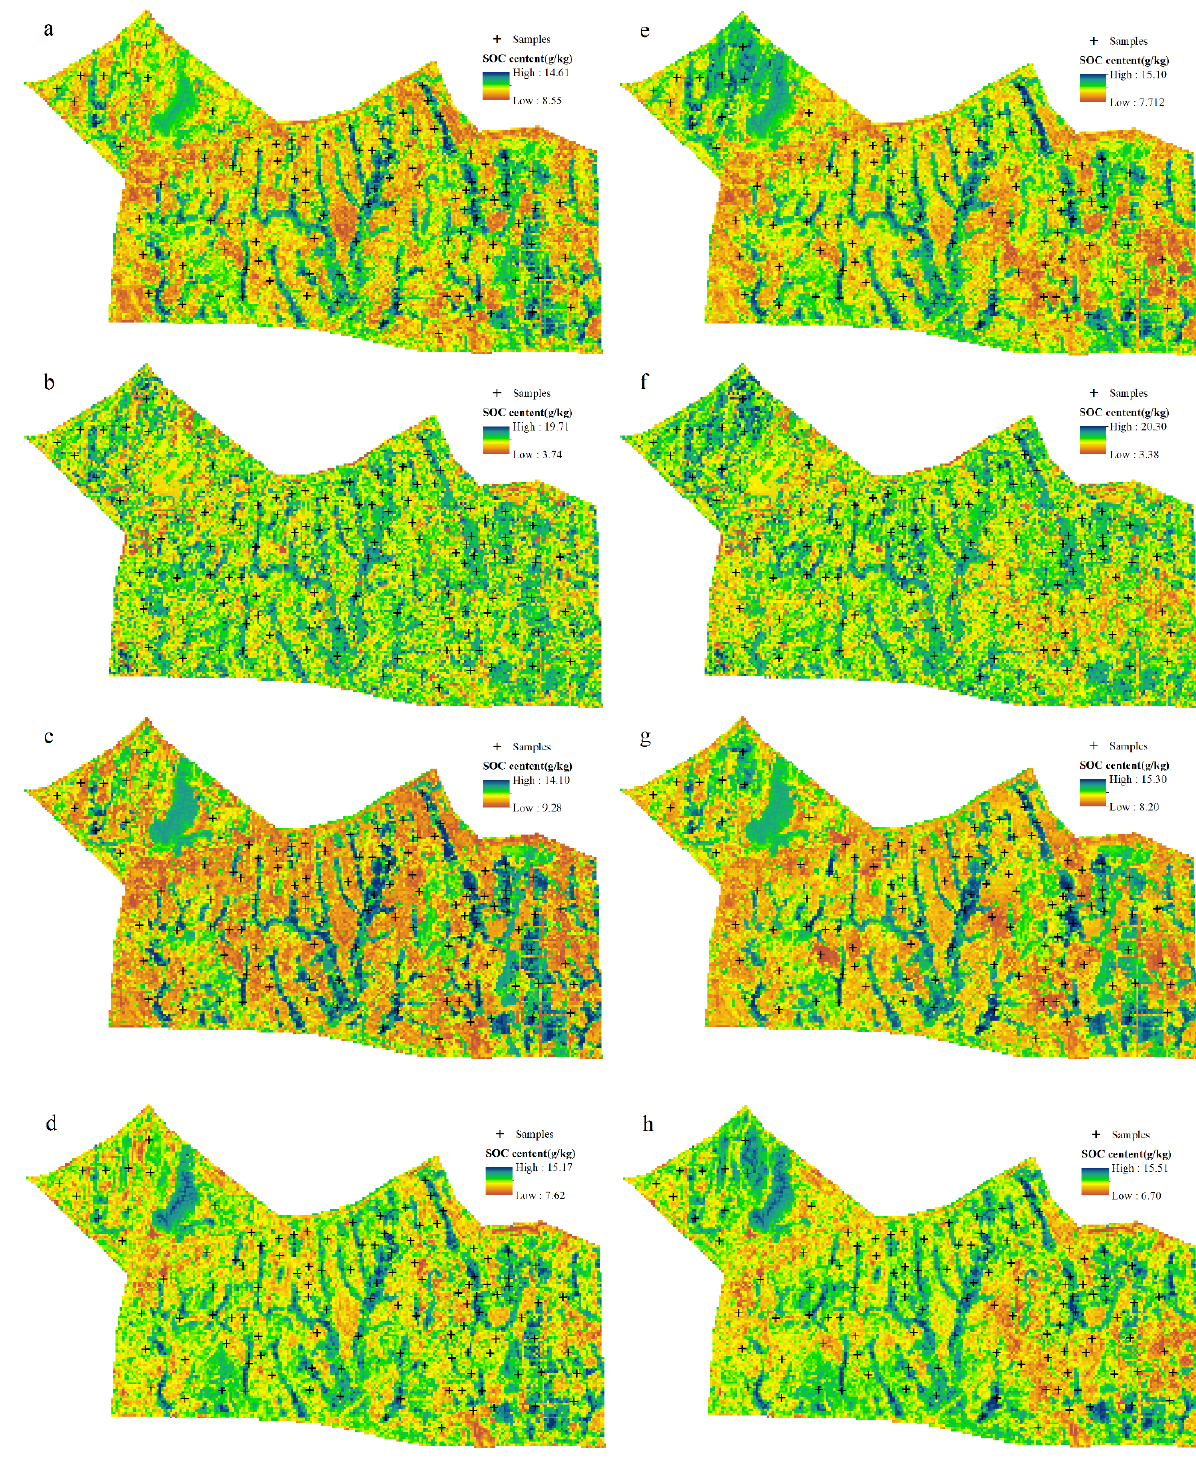
Figure 8. Spatial distribution of SOC predicted by trend models and RK models: ( a ) ranger, ( b ) Cubist, ( c ) GBM, ( d ) BRNN, ( e ) RK-ranger, ( f ) RK-Cubist, ( g ) RK-GBM, ( h ) RK-BRNN.